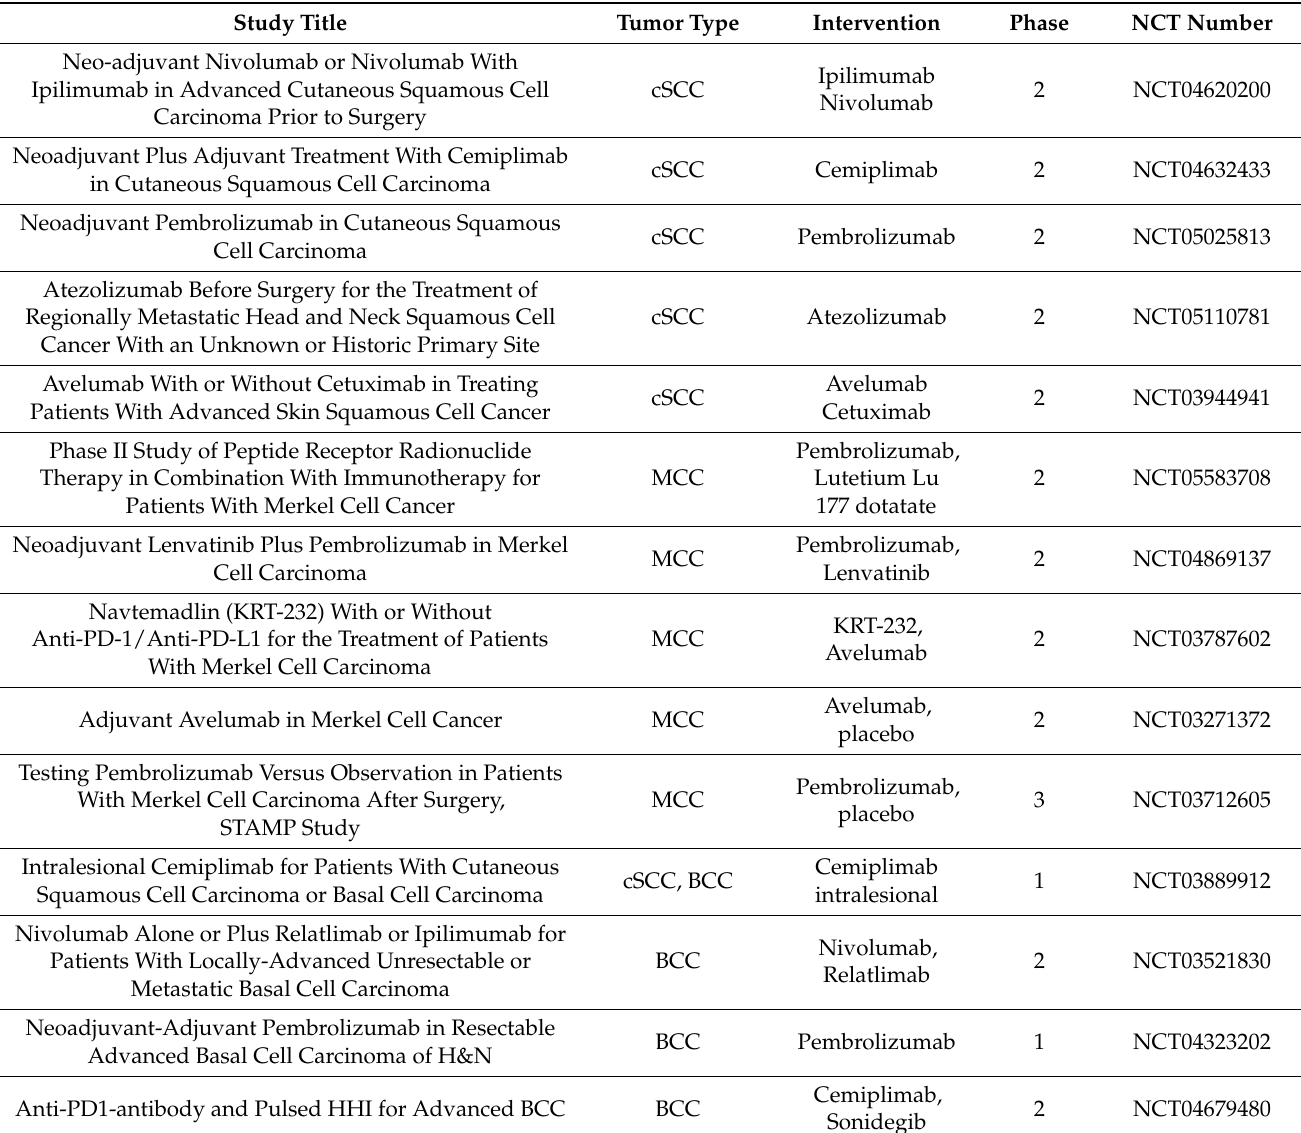
Table 3. Ongoing clinical trials with different types of ICI in NMSC (as assessed on 13 November